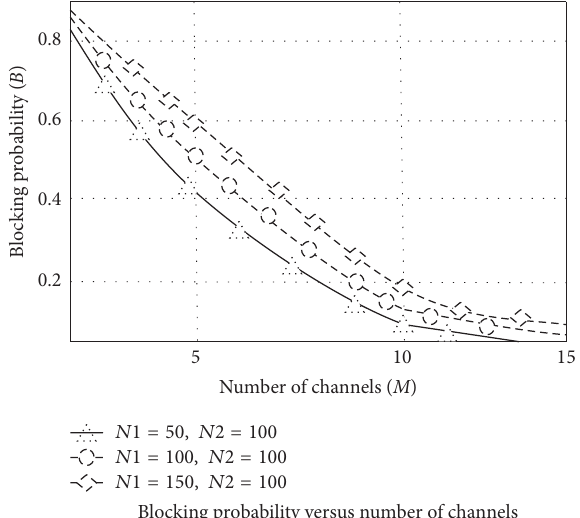
Figure 2: Variation of blocking probability against the number of channels of the BTS.